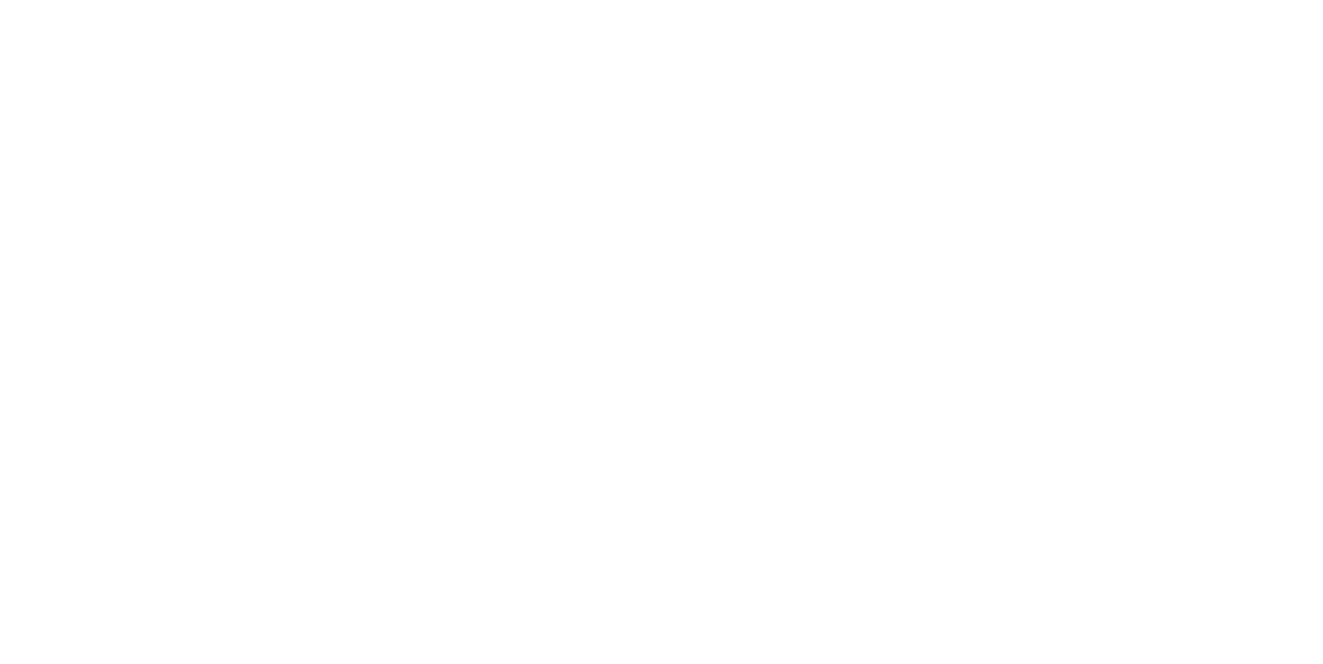
Frontiers in Environmental Chemistry |